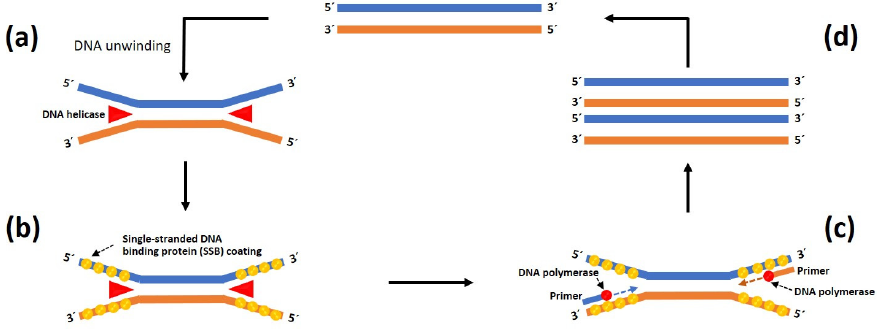
Figure 8. Schematic overview of the helicase ‐ dependent amplification system used to detect P. insidiosum . ( a ) Target double ‐ stranded DNA (dsDNA) is isothermally separated into single ‐ stranded P. insidiosum . ( a ) Target double-stranded DNA (dsDNA) is isothermally separated into single-stranded DNAs (ssDNA) by helicase and ( b ) stabilized by the single ‐ stranded DNA ‐ binding protein (SSB). DNAs (ssDNA) by helicase and ( b ) stabilized by the single-stranded DNA-binding protein (SSB). ( c ) Two target sequence ‐ specific primers anneal the 5 ′ and 3 ′ defined borders of the target ssDNA. ( c ) Two target sequence-specific primers anneal the 5 (cid:48) and 3 (cid:48) defined borders of the target ssDNA. Subsequently, DNA polymerase elongates the primer sequences to obtain new dsDNA amplification products. ( d ) This helicase-dependent amplification is repeated continuously, resulting in exponential amplification of the target DNA sequence. The diagram is adapted from the reference